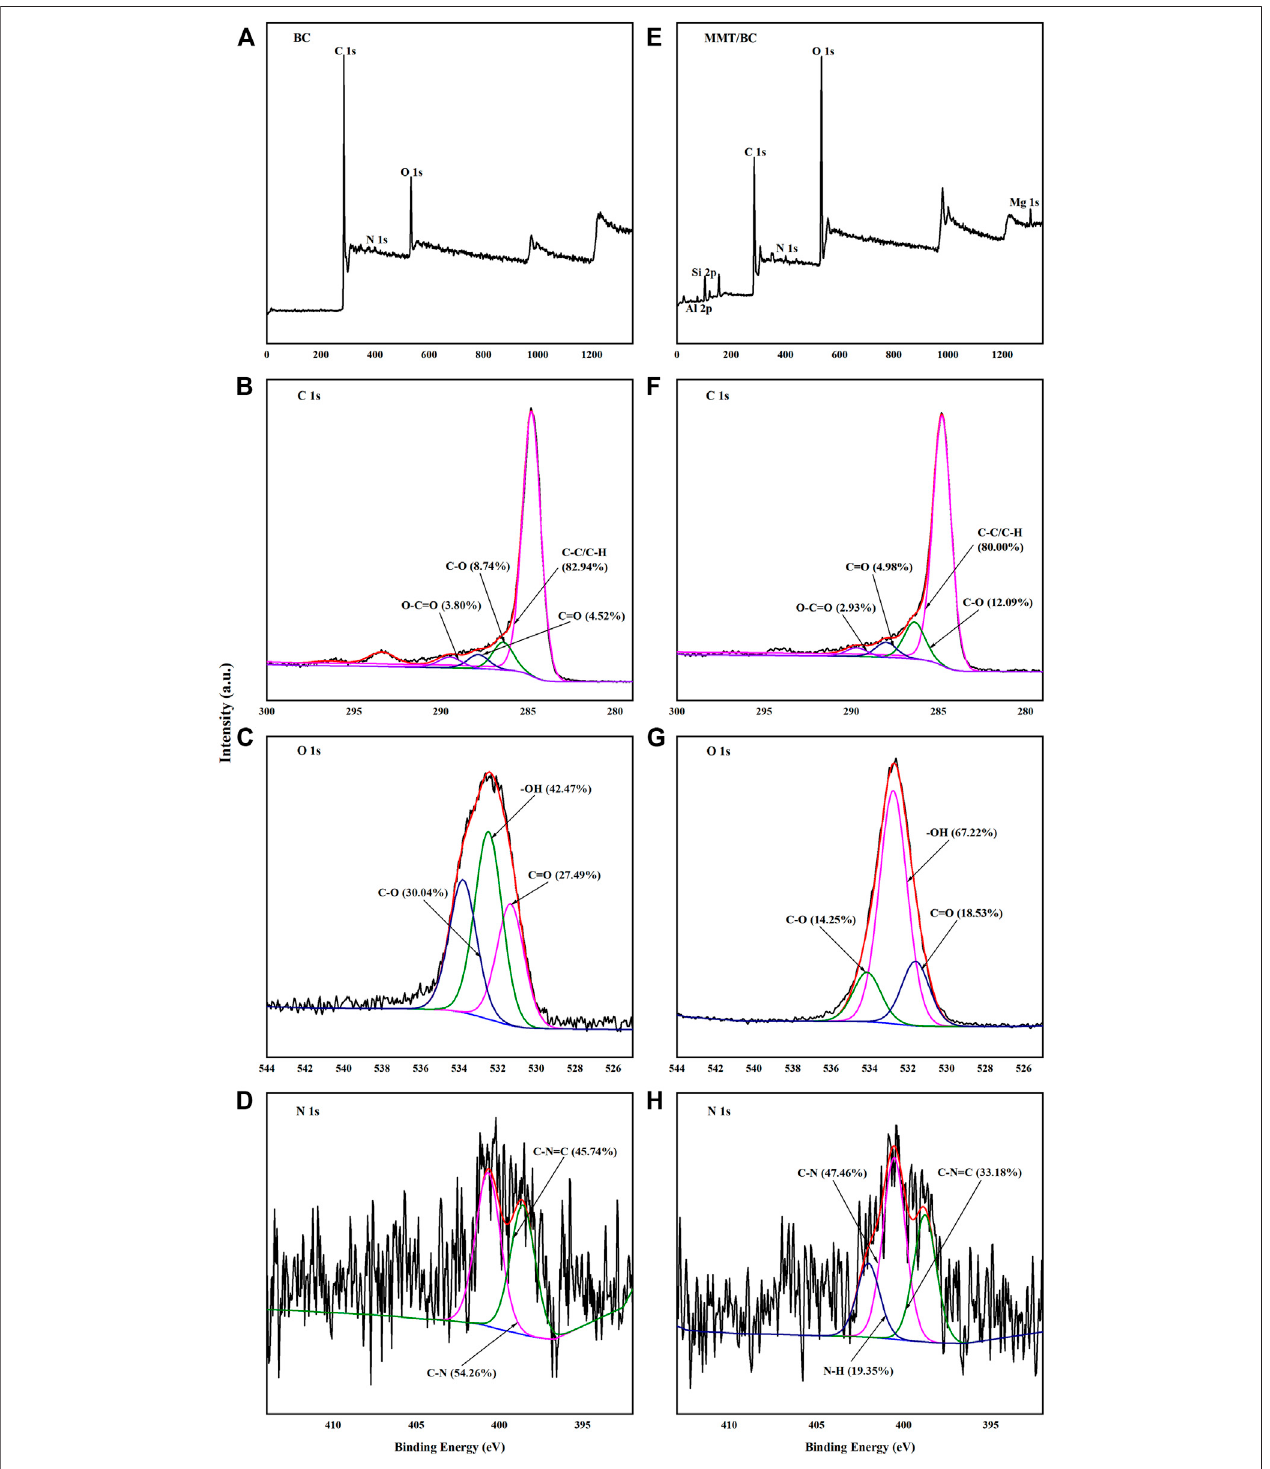
FIGURE 3 | XPS spectra of BC (A – D) and MMT/BC (E – H) . (A,E) Wide survey scan, (B,F) C 1s, (C,G) O 1s, (D,H) N 1s.